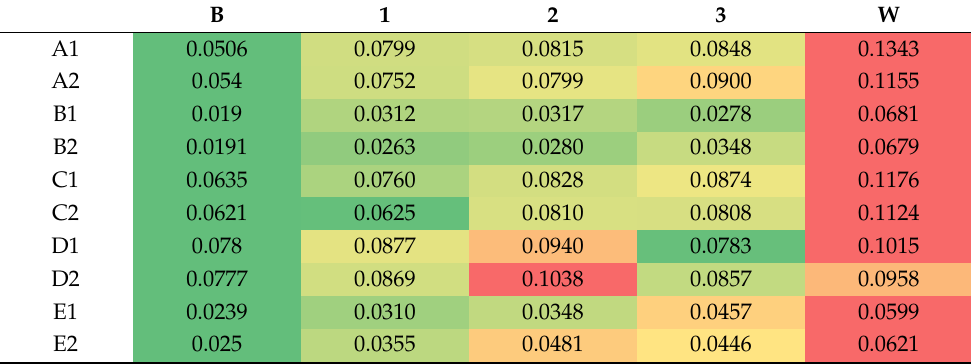
Table 4. Fitness function values in the five robot locations for individual trajectories–results from the real robot. Color gradient red–yellow–green is used for better visual representation of the value (green is the best, red is the